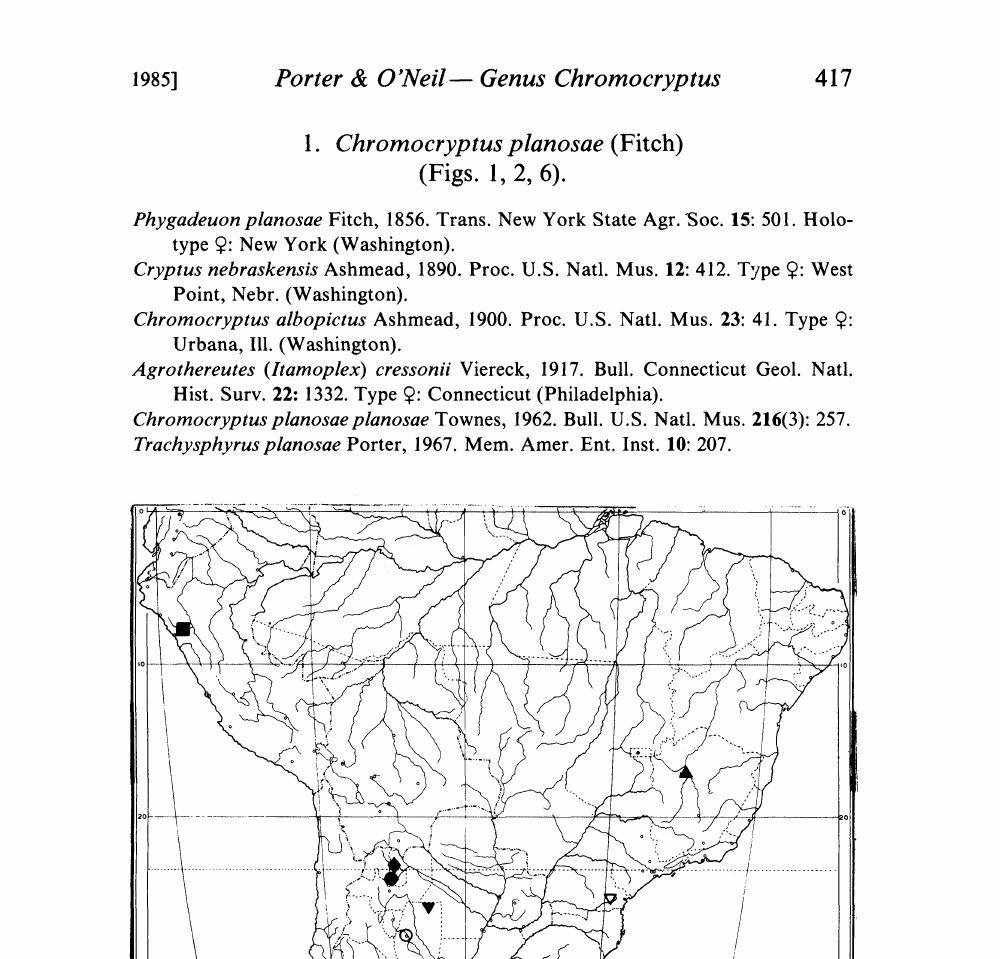
Fig. 1. Distribution map for Chromocryptus in tropical and subtropical South